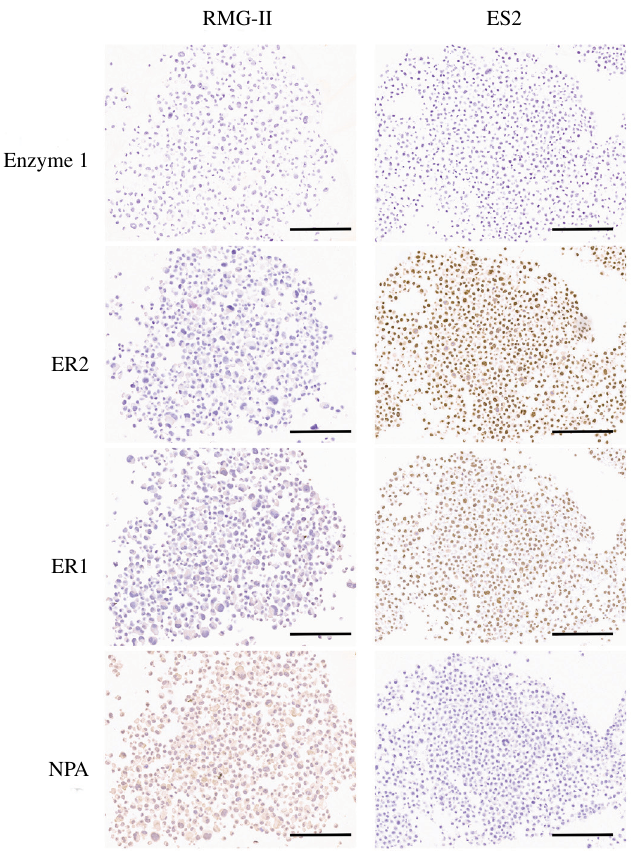
Figure 2. ES2 and RMG-II cell lines stained by immunohistochemistry with anti-ARID1A using three antigen retrieval conditions, ER1, ER2 and Enzyme 1. NPA denotes No Primary antibody control and represents the ER2 condition. Bar = 200